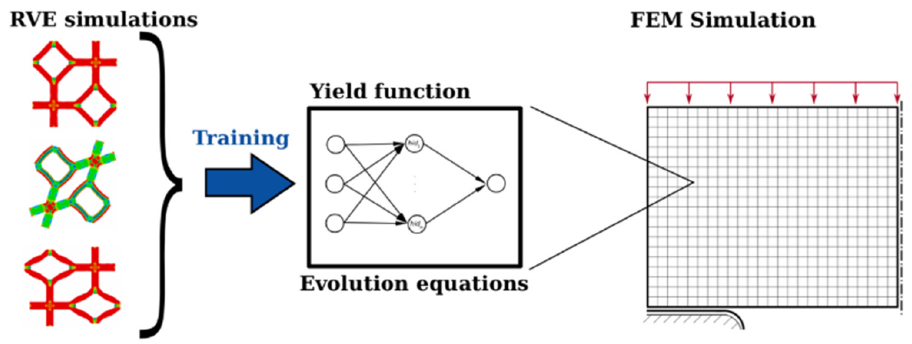
Figure 5 . Graphical representation of a machine learning approach by Settgast et al.[36] . Figure 5. Graphical representation of a machine learning approach by Settgast et al. [36].